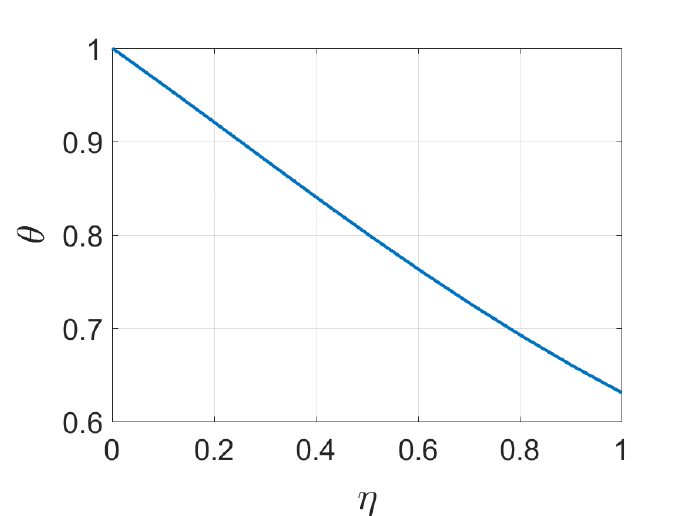
Figure 4. Temperature